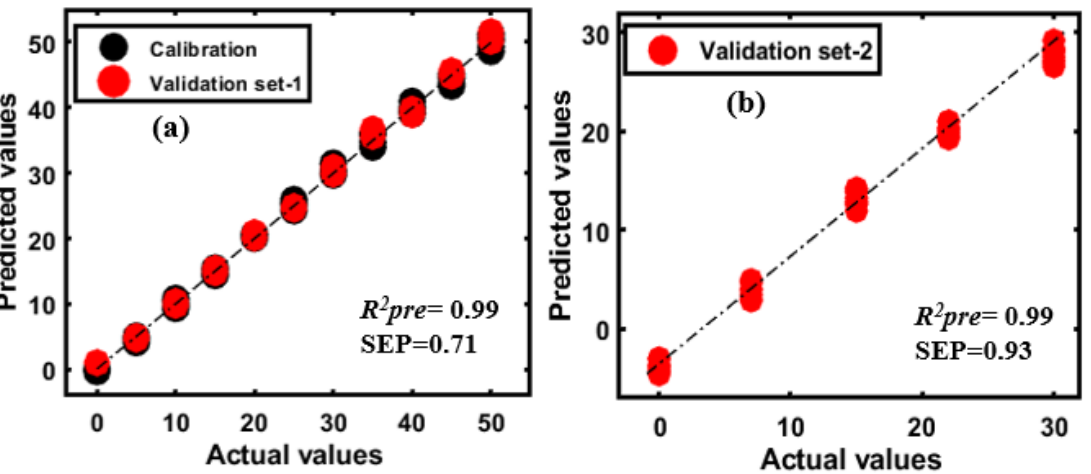
Figure 10. ( a ) PLSR prediction plots for apricot-adulterated almond (first variety); ( b ) results for the second variety of almond adulterated with apricot.